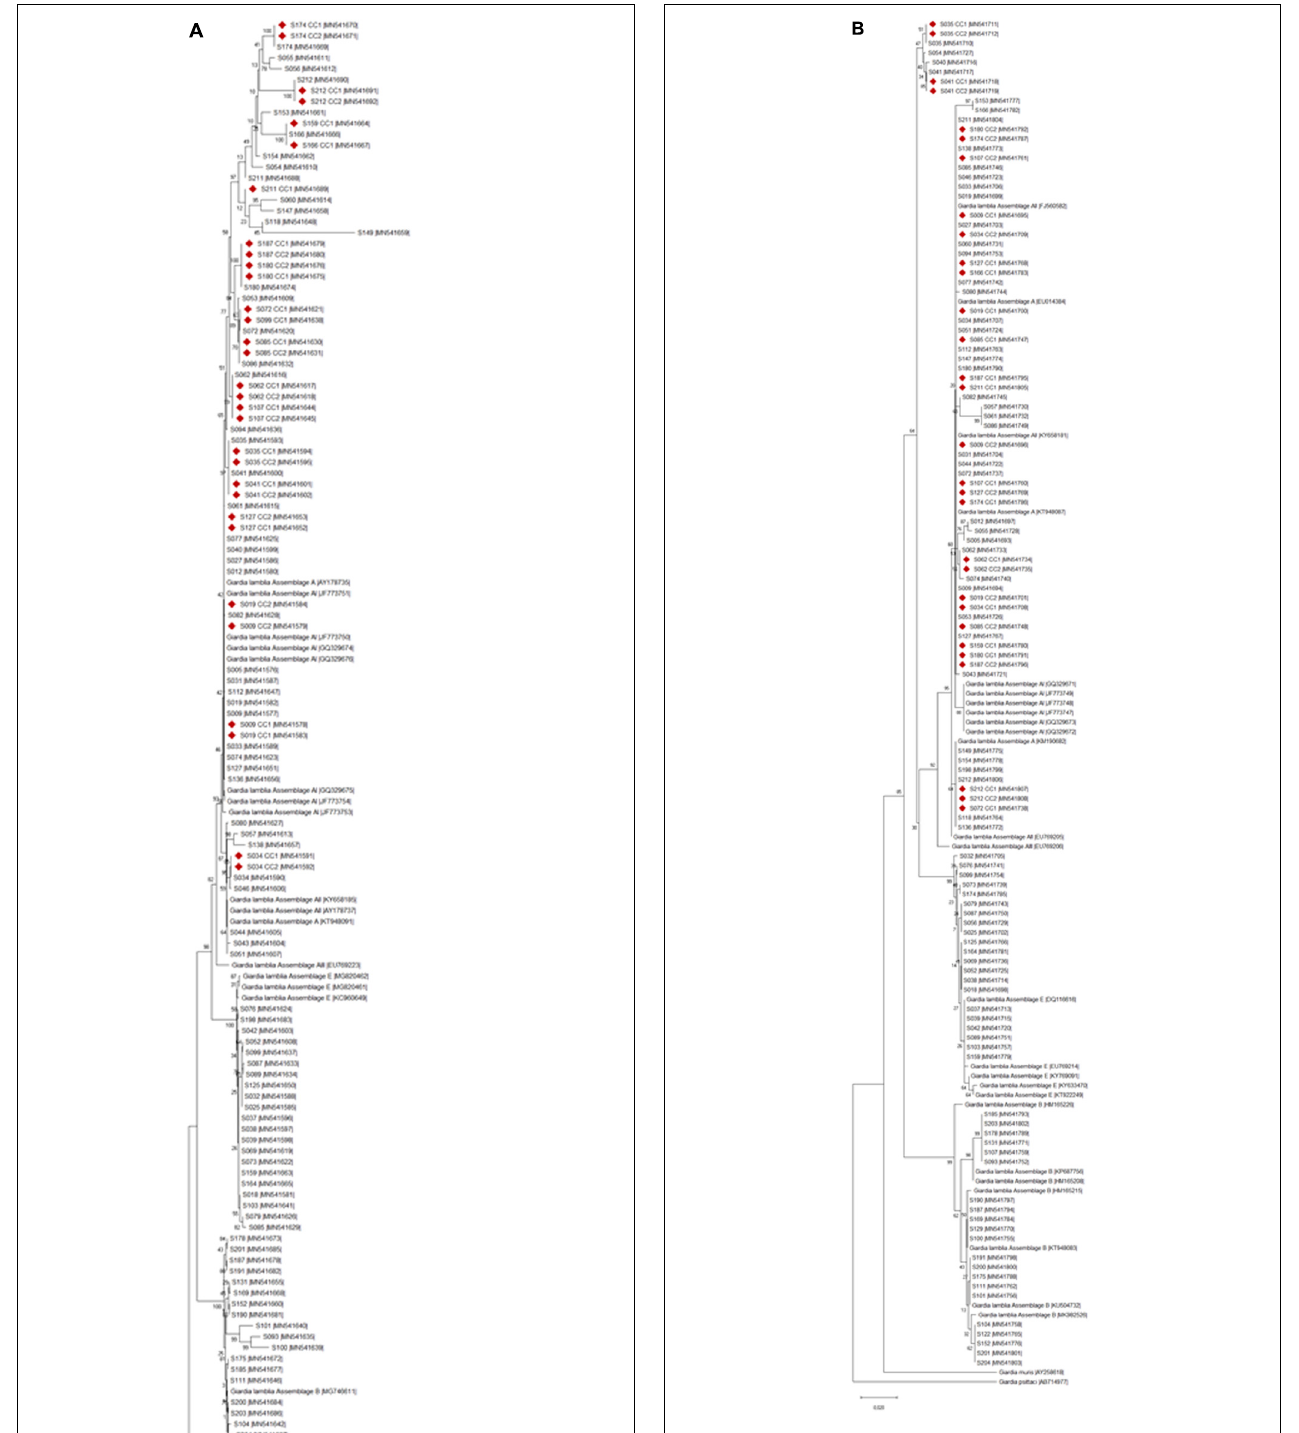
FIGURE 3 | Phylogenetic tree of the Giardia lamblia isolates collected from children before and after treatment, by the neighbor-joining algorithm using a Kimura two-parameter. (A) Phylogenetic tree based on sequences of the glutamate dehydrogenase gene. (B) Phylogenetic tree based on sequences of the beta-giardin gene. The name sequences are indicated by their accession numbers. Red diamond: CC1: isolate from sample of first cure control, and CC2: isolate from sample of second cure